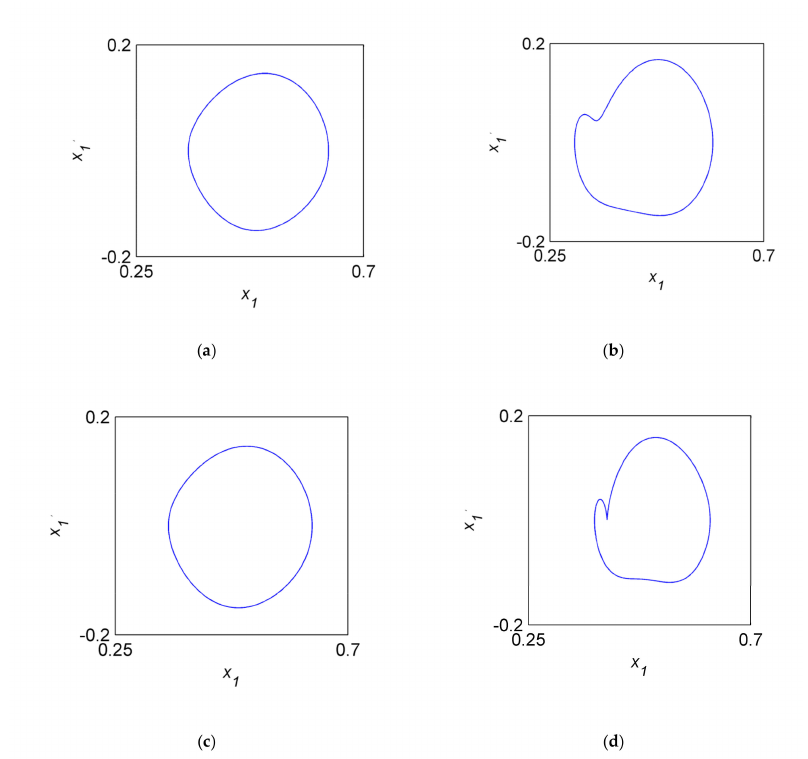
Figure 7. The phase portraits of o 1 when ω = 350 rad/s. ( a ) The oil-filmed system. ( b ) The cracked system. ( c ) The rub-impacted system. ( d ) The coupled